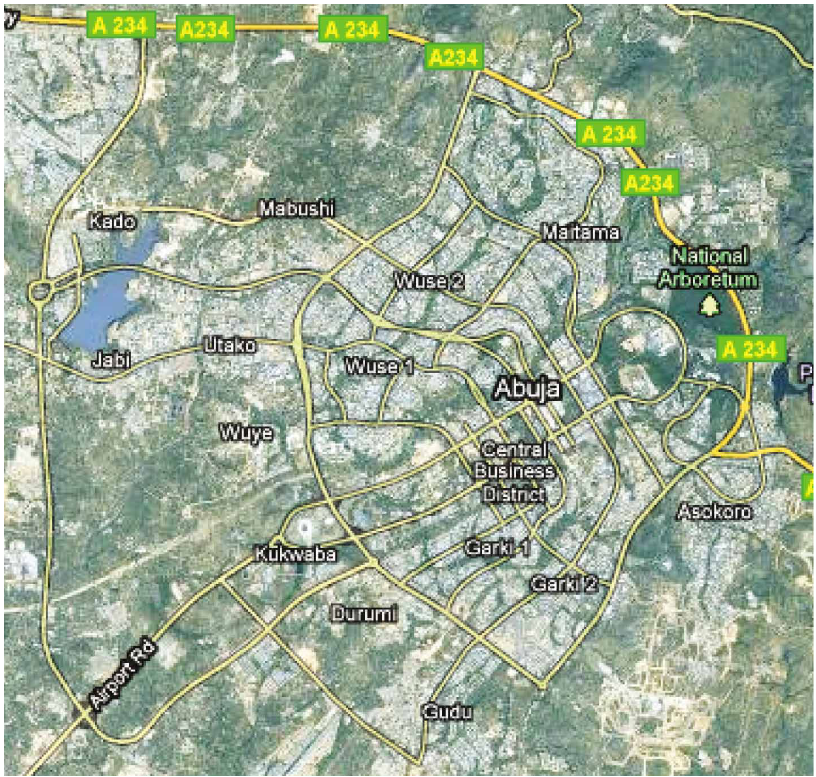
Figure 4. Google Map of districts in Federal Capital City of Abuja (adapted from Google Map